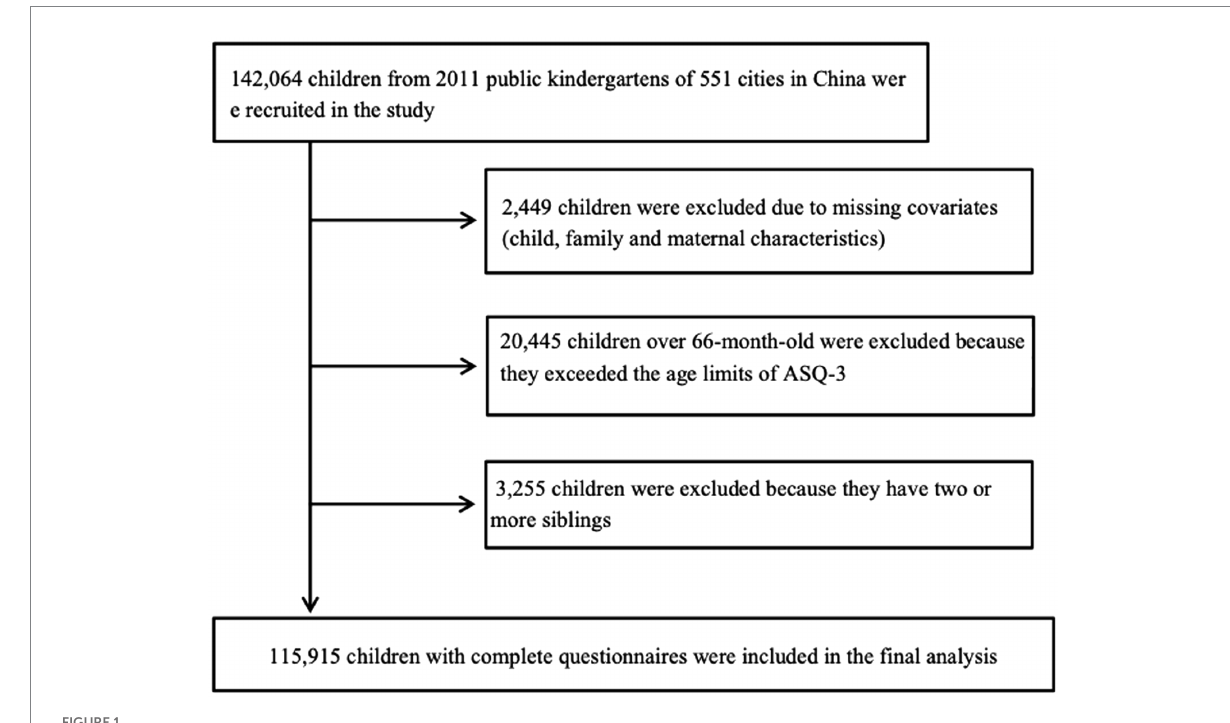
FIGURE 1 Flowchart of the study